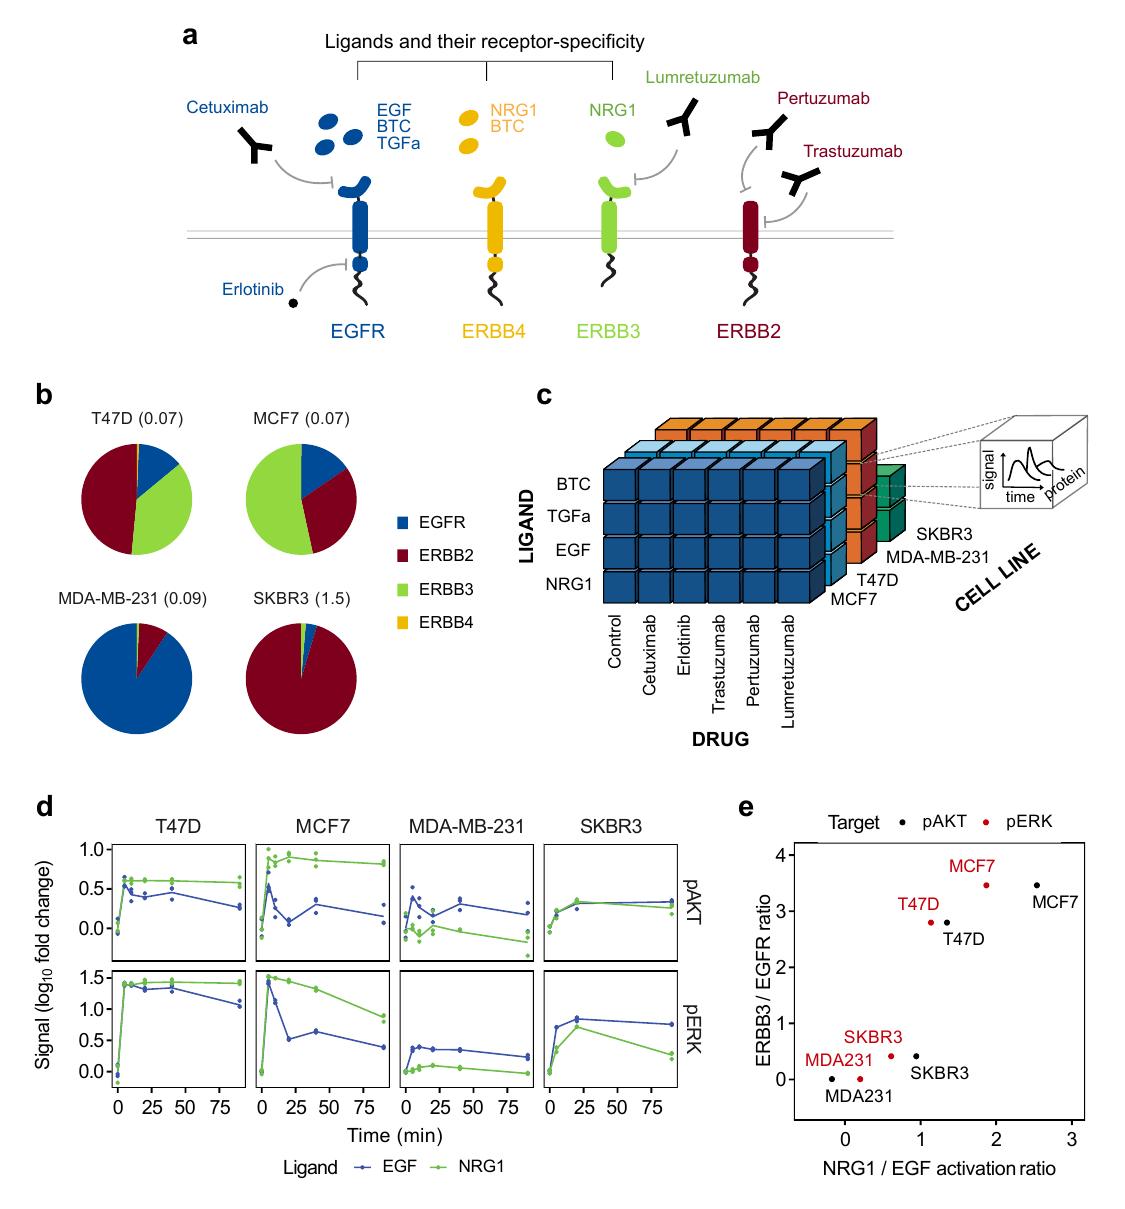
Figure 1. The ERBB receptor composition in relation to the downstream signaling response. ( a ) Overview of ERBB receptors and their interactions with specific ligands and antagonistic in- hibitors. ERBB2 is missing a ligand-binding domain, whereas ERBB3 is lacking a kinase domain. ( b ) The ERBB receptor composition of the four analyzed cell lines. Numbers in parentheses indi- cate the total amount of ERBB receptors in pg/cell and were taken from Niepel et al. [54]. ( c ) The experimental data set comprises dynamic protein measurements of four different ligand stimulations combined with five drug pre-treatments and a control for four cell lines. The resulting experimental conditions per cell line are depicted as a cube each. In every condition, dynamic alterations of several proteins and phospho-proteins were quantitatively assessed. ( d ) Time-resolved activation dynamics of AKT and ERK were quantified from RPPA measurements for T47D, MCF7, MDA-MB-231 and SKBR3 cells. The three biological replicates are displayed as dots, and lines represent linear interpola- tions. ( e ) Linear correlation of the activation ratio of downstream signaling components by NRG1 vs. EGF and the ERBB3 vs. EGFR expression ratio. The activation of AKT and ERK was assessed using the area under the curve (AUC) of each stimulus shown in panel ( e